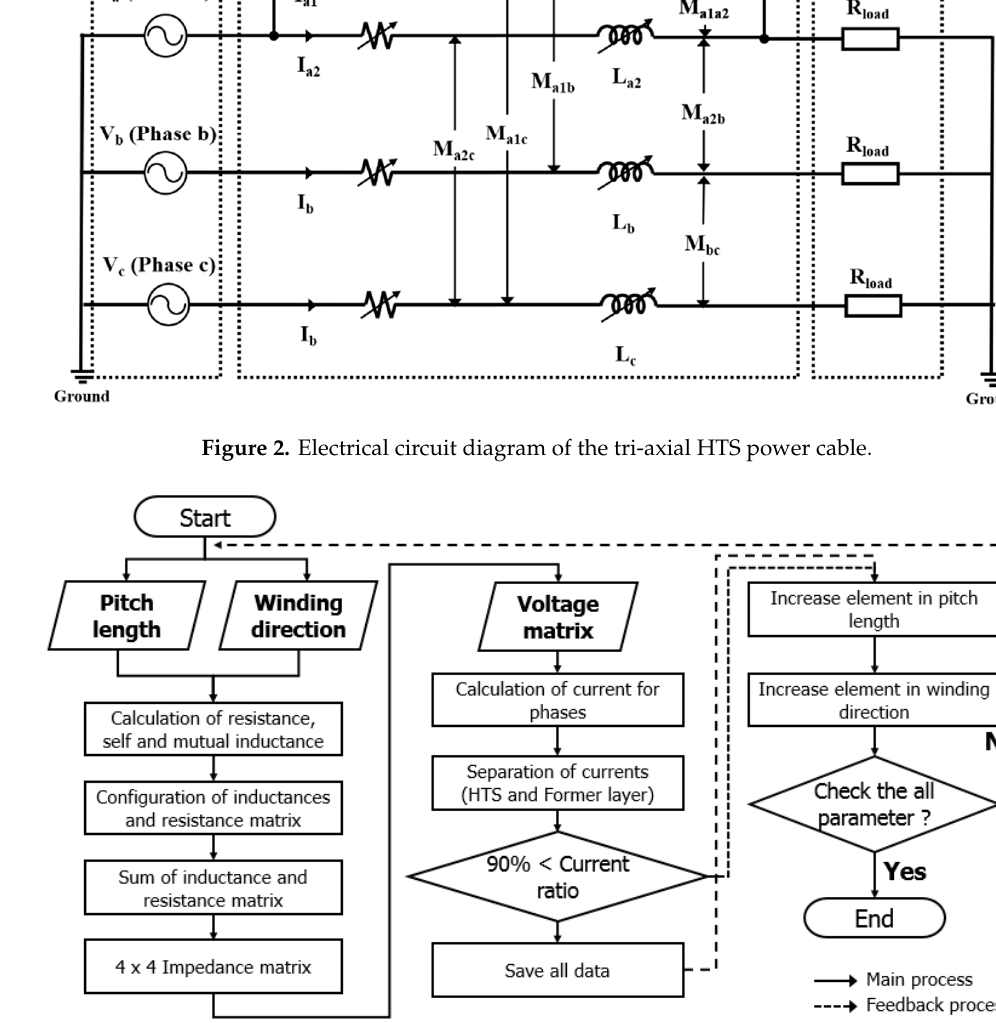
Figure 3. Block diagram for impedance matching of the tri-axial HTS power cable.